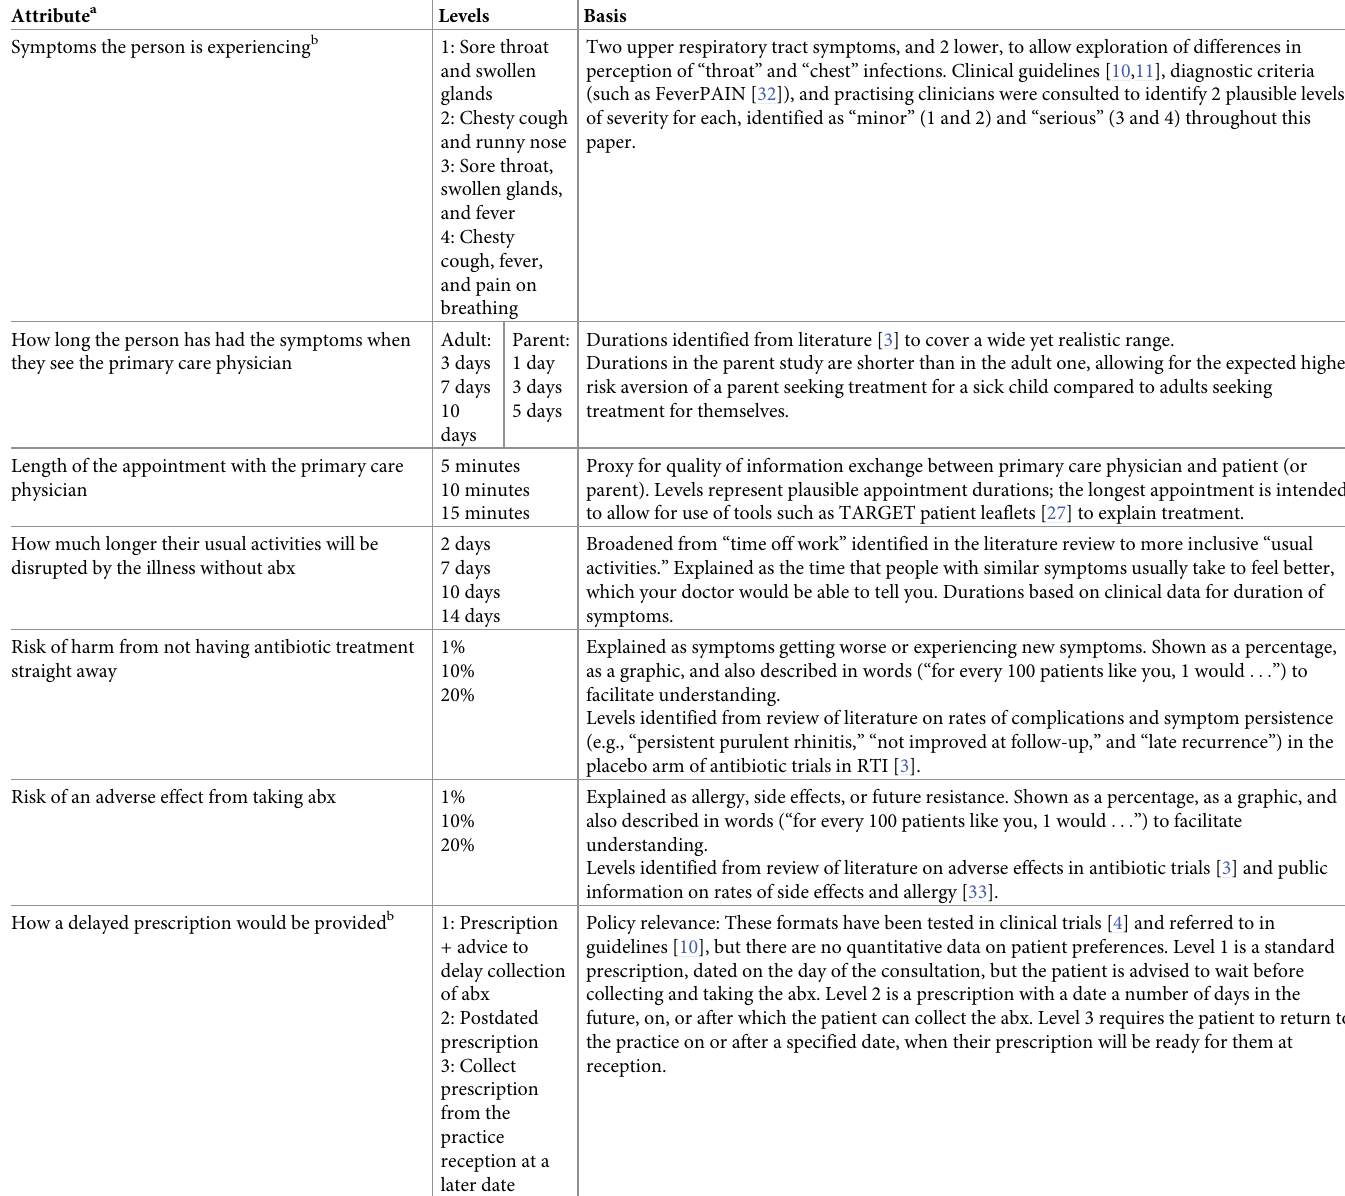
Table 1. Attributes and levels for the choice questions. Attribute a